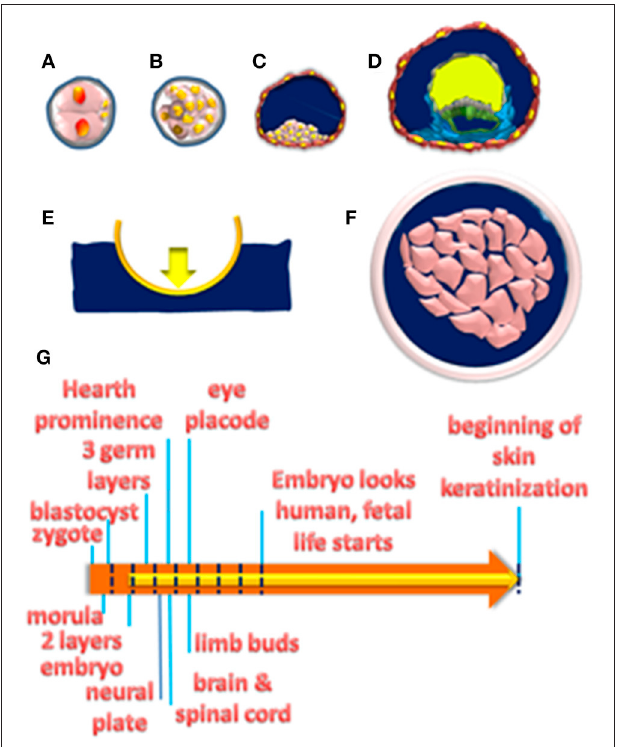
FIGURE 1 | (A–D) Schematic representation of the main embryonic developmental stages. Two-cell zygote (A) ; compact cell mass at morula (B) ; blastocyst stages (C) ; with trophoblast cells (brown) encircling a cavity filled by fluid (blue) where the inner cell mass (pink) sits at one pole. In (A,B) cells are encased by the zona pellucida (gray). Zygote development up to the blastocyst stage does occur before implantation. (D) Formation of hypoblast (gray) and epiblast (green) layers after implantation. The initial amniotic cavity is delimited by epiblast cells and filled with fluid (blue). The cavity above the hypoblast is the yolk sac, which fills up with the yolk (yellow) and regresses at later developmental stages. (E) A boat in the fluid will sink or float, depending on the difference between the force of gravity (downward pointing yellow arrow) and the buoyant force (upward pointing blue arrow). The rigid hull absorbs the opposing forces and people inside the floating boat do experience gravity. (F) A cell mass (pink) immersed in a fluid (blue) that has access to the interstitial fluid between cells. (G) The orange arrow plots the timeline of organ morphogenesis between implantation and the 20th week when skin keratinization starts. The yellow arrow plots the time of amniotic fluid formation. Blue dashed lines plot 1-week intervals till the 8th week when fetal life starts.